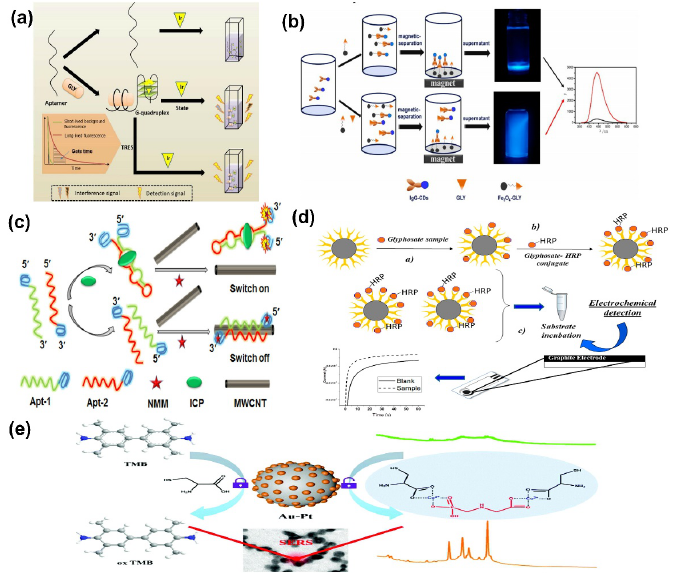
Figure 9. Schematic representation of the detection strategy by aptasensors, immunosensors, and nanozyme-based sensors and their assembled procedures used to develop pesticide sensors. ( a ) The scheme shows the aptamer-based sensing system’s operation for GLYP employing G-quadruplex- selective iridium (III) complex in TRES mode. Adapted with permission from [122]. Copyright 2020 Elsevier. ( b ) Schematic representation of detection principle using carbon dots labeled antibody and antigen magnetic beads for GLYP detection. Adapted with permission from [127]. Copyright 2016 ACS Publications. ( c ) Schematic representation of the label-free and enzyme-free fluorescent isocar- bophos (ICP) aptasensor using multiwalled carbon nanotubes (MWCNTs) and G-quadruplex as the signal transducers. Adapted with permission from [128]. Copyright 2018 Elsevier. ( d ) Scheme of the electrochemical immunoassay coupled with disposable screen-printed carbon electrode. Steps to develop paramagnetic beads modified with anti-GLYP antibodies and horseradish peroxidase (HRP) (a, b, and c). Adapted with permission from [129]. Copyright 2018 MPDI. ( e ) Schematic illus- tration of the sensing process of GLYP-based an Au–Pt nanozyme. Adapted with permission from [126]. Copyright 2021 Royal Society Chemistry.